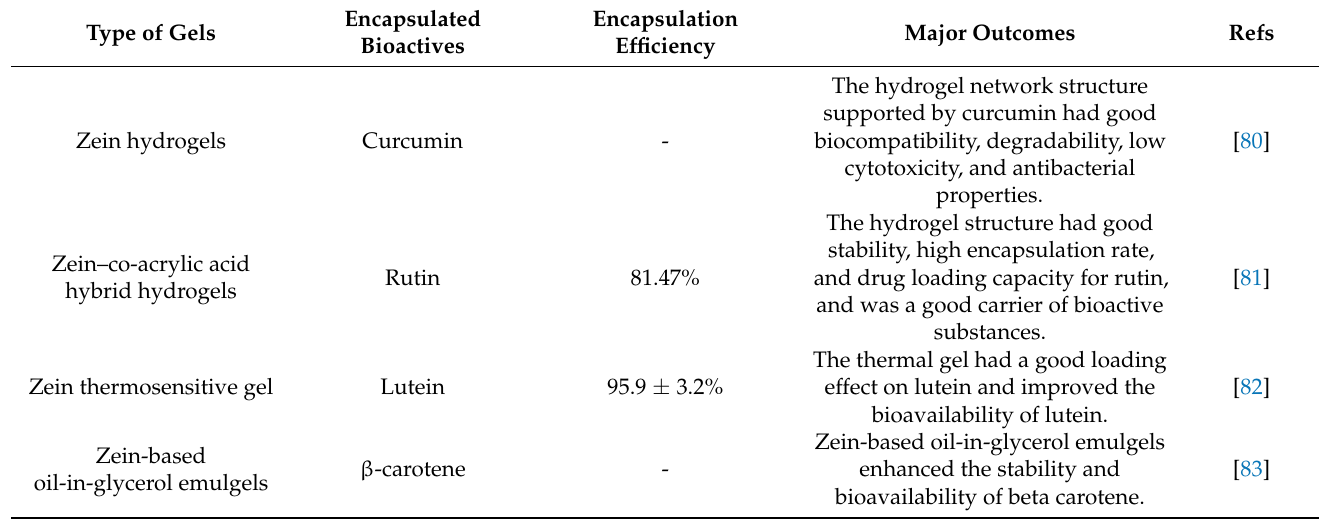
Table 2. Plant protein-based gels and emulsions for bioactive ingredient